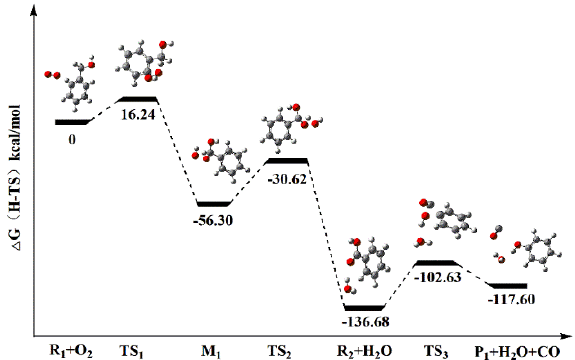
Figure 8. Sketch map of the reaction potential energy profile of reaction path a.